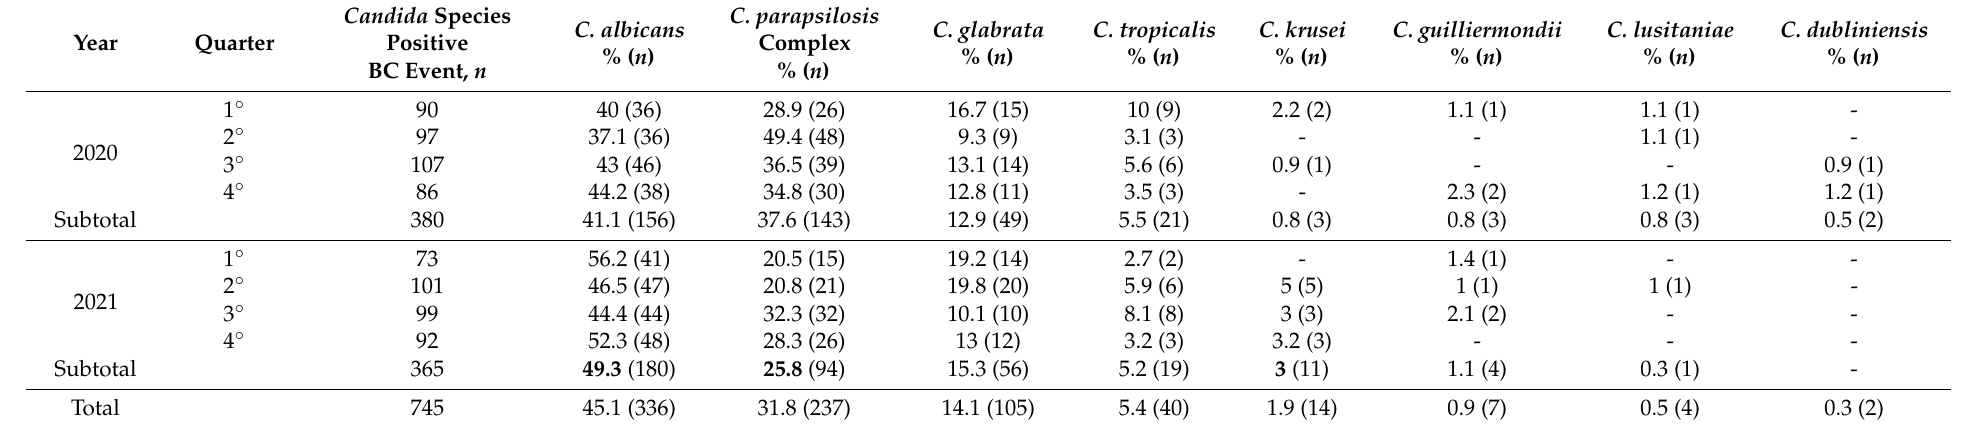
Table 1. Distribution per year of Candida species positive blood culture events.